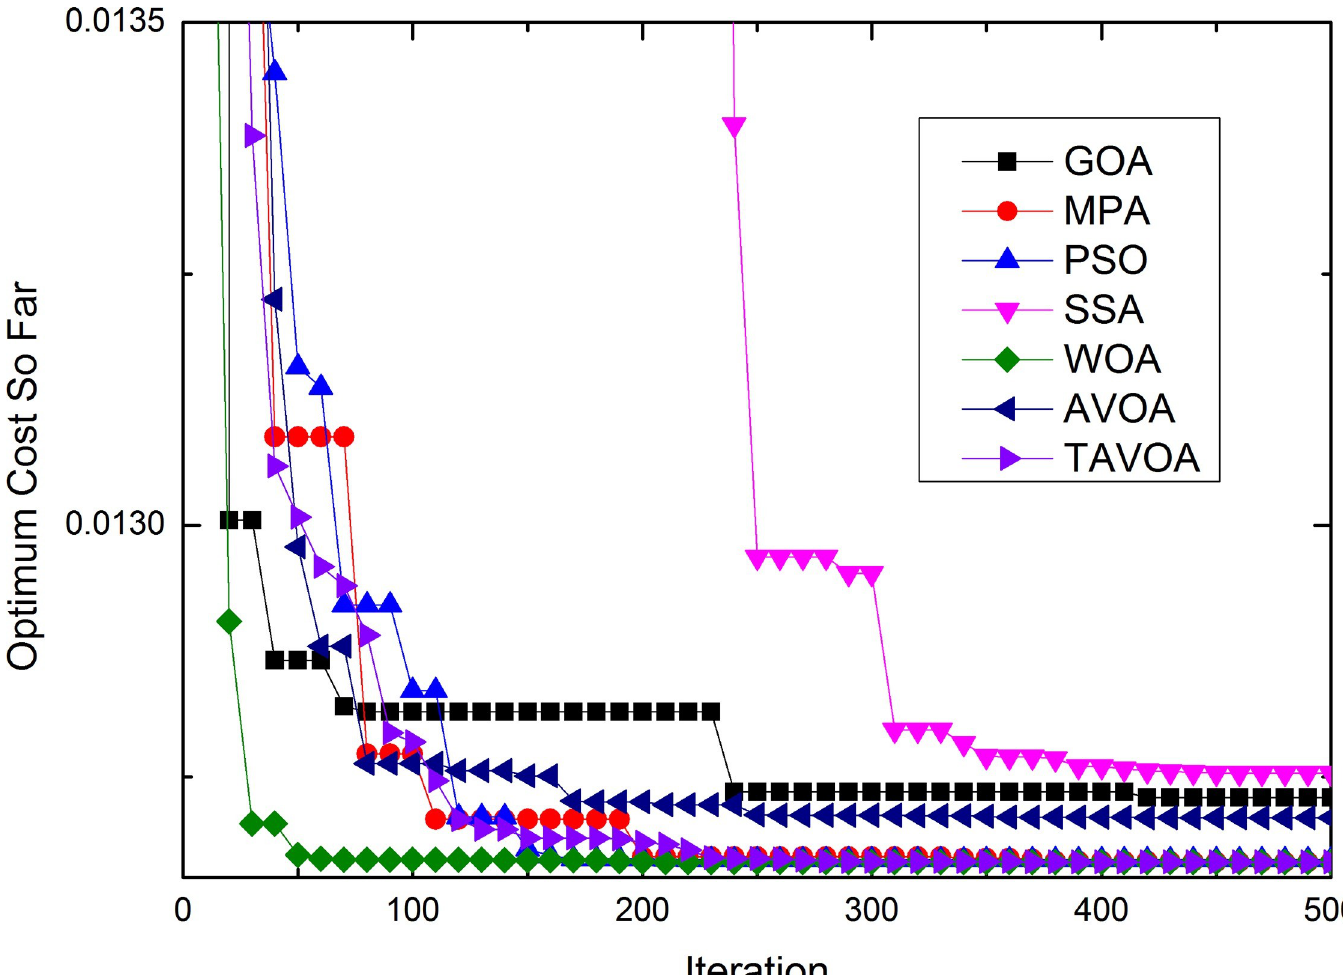
Fig 17. Convergence process in the compression/tension spring design